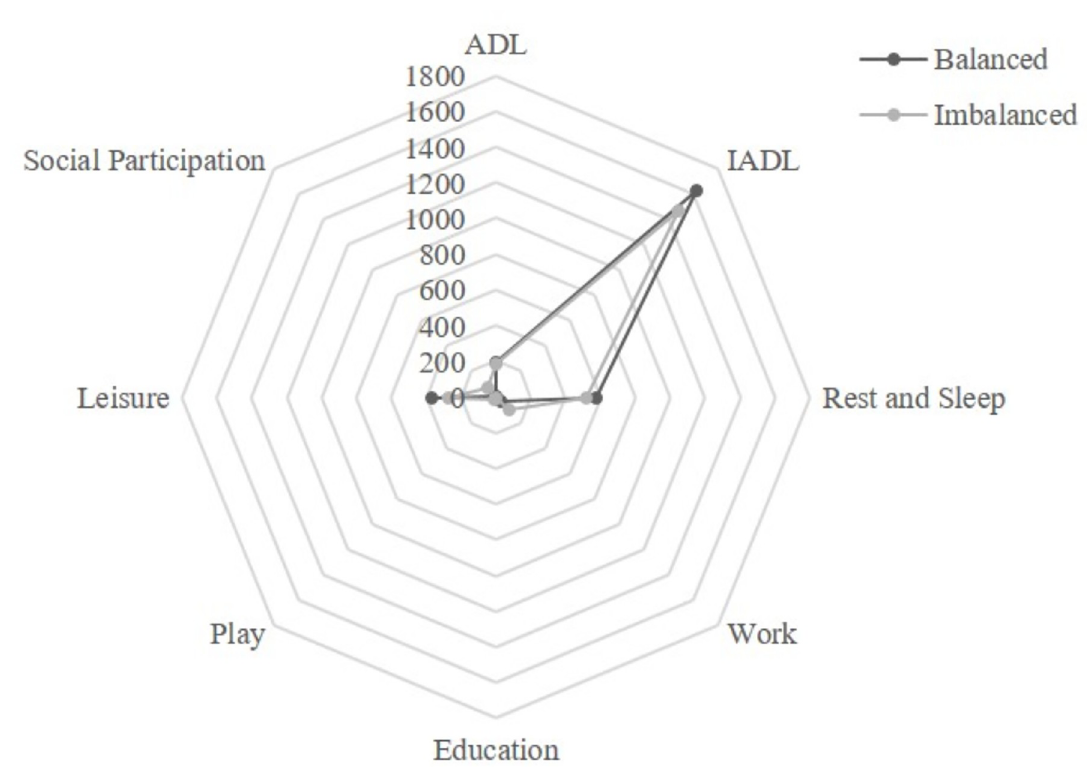
Fig 2. Comparison of time-use between the occupational balance (OB) group and occupational imbalance (OI) group.